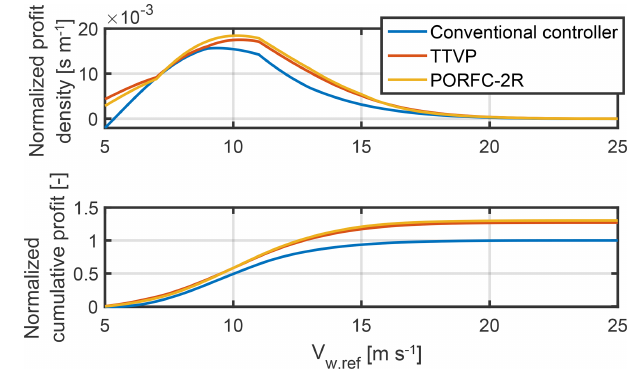
Figure 9. Normalized profit density and cumulative profit. The lat- ter is normalized with respect to the total profit of the conventional